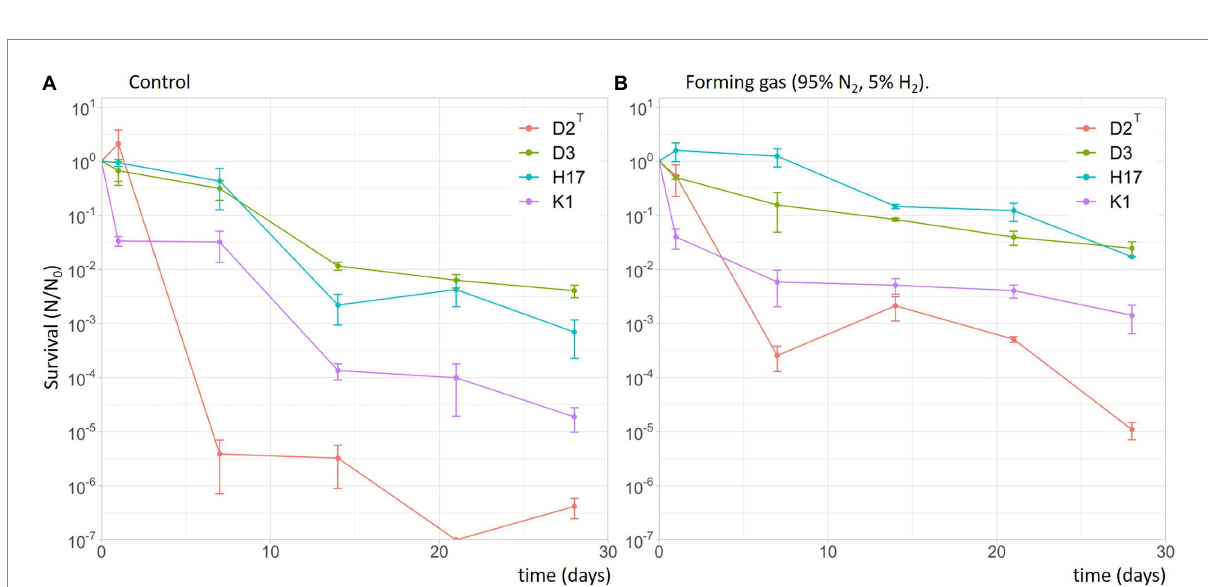
FIGURE 9 Survival of S. capitis strains during desiccation for up to 28 days in normal atmospheric conditions in the laboratory as control (A) and in forming gas inside an anaerobic chamber (B) . Initial cell counts were 10 7 CFU/mL. Experiment was performed in biological triplicates. Error bars represent the calculated standard